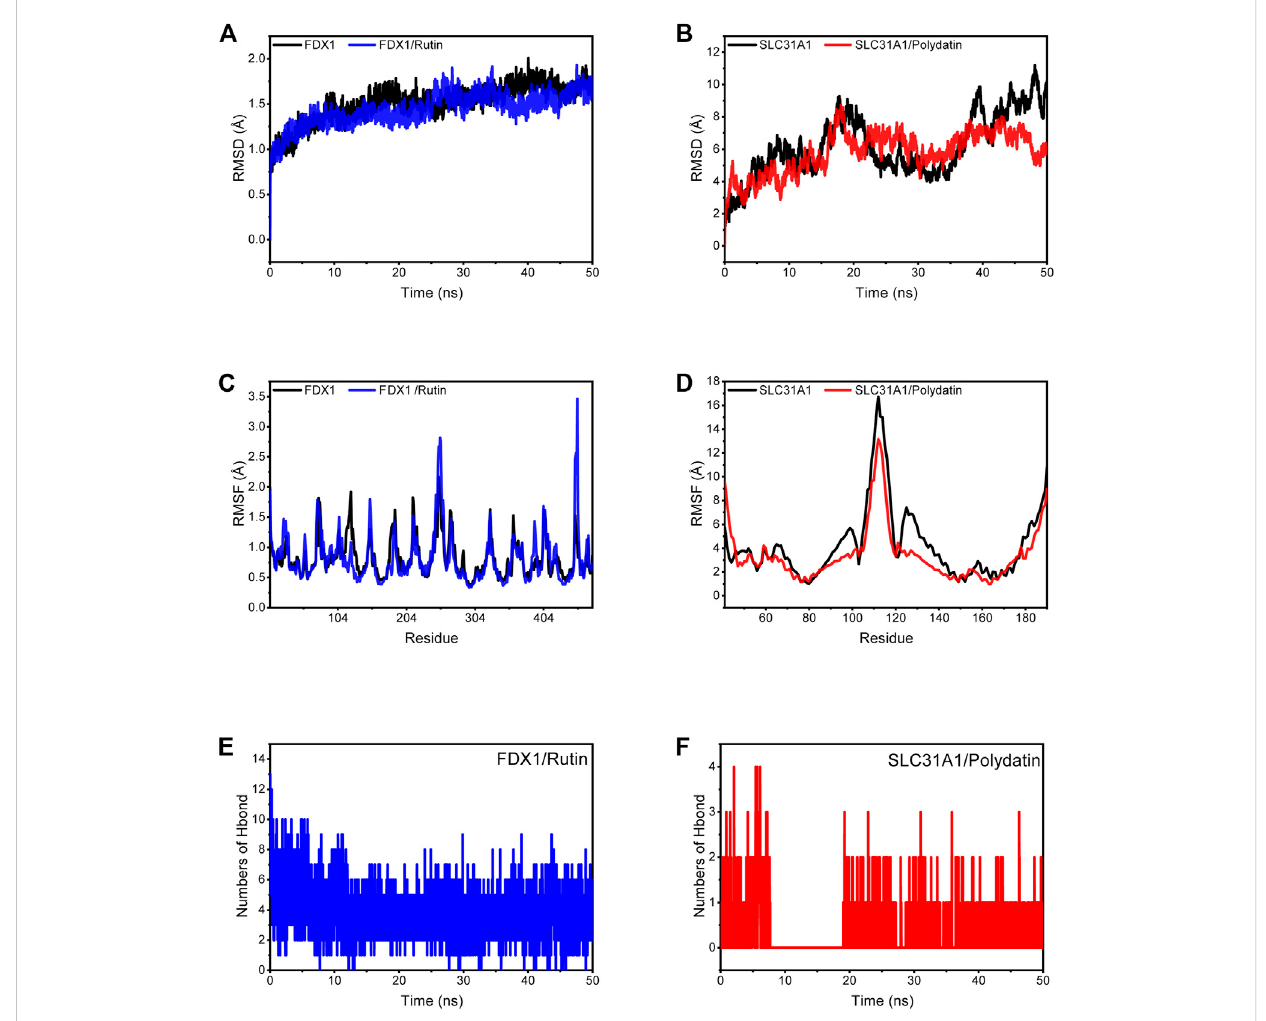
FIGURE 10 Molecular dynamics simulation. (A) RMSD plot showing FDX1, FDX1/Rutin along with time change. (B) RMSD plot showing SLC31A1, SLC31A1/ Polydatin along with time change. (C) RMSF of FDX1 and FDX1/Rutin complex. (D) RMSF of SLC31A1 and SLC31A1/Polydatin complex. (E) Changes in the number of hydrogen bonds in the FDX1/Rutin. (F) Changes in the number of hydrogen bonds in the SLC31A1/Polydatin.